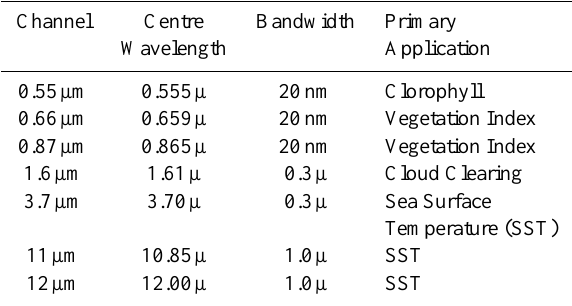
Table 3. Table of the AATSR spectral channels and their applica-